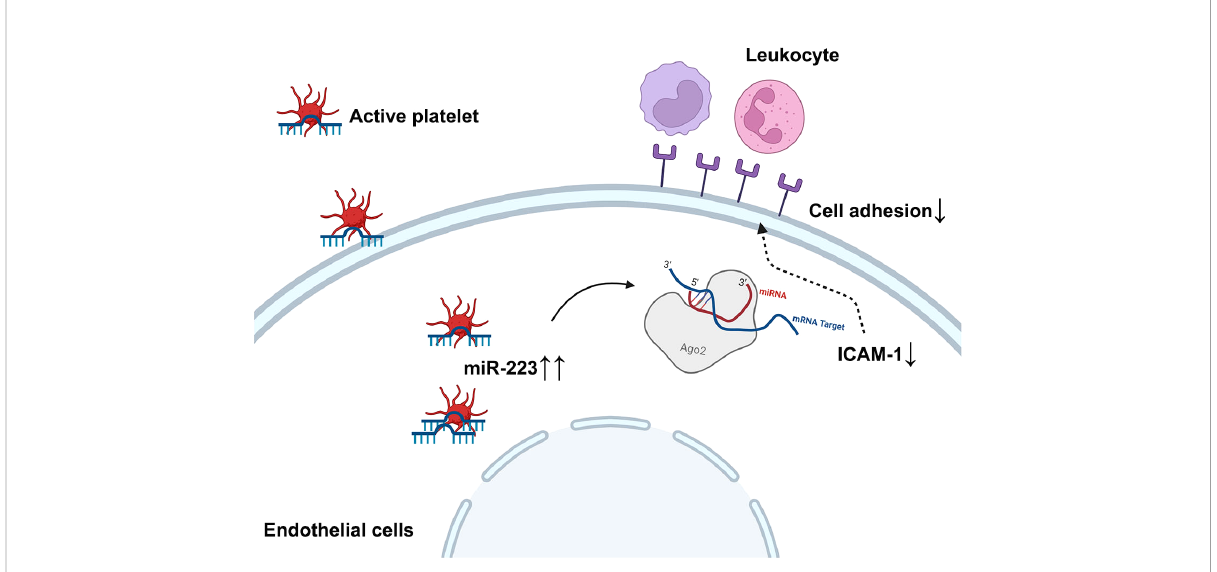
FIGURE 7 Schematic fi gure of the working model diagram of the regulatory function of platelet-derived miR-223 in endothelial cells. In the case of KD, platelets are hyperactive and internalized into HCAECs. The horizontal transfer of platelet derives miR-223 to HCAECs, which suppress the expression of ICAM-1 in HCAECs and partially attenuates leukocyte adhesion, thereby reducing further endothelial damage in KD vasculitis. ICAM-1, intercellular cell adhesion